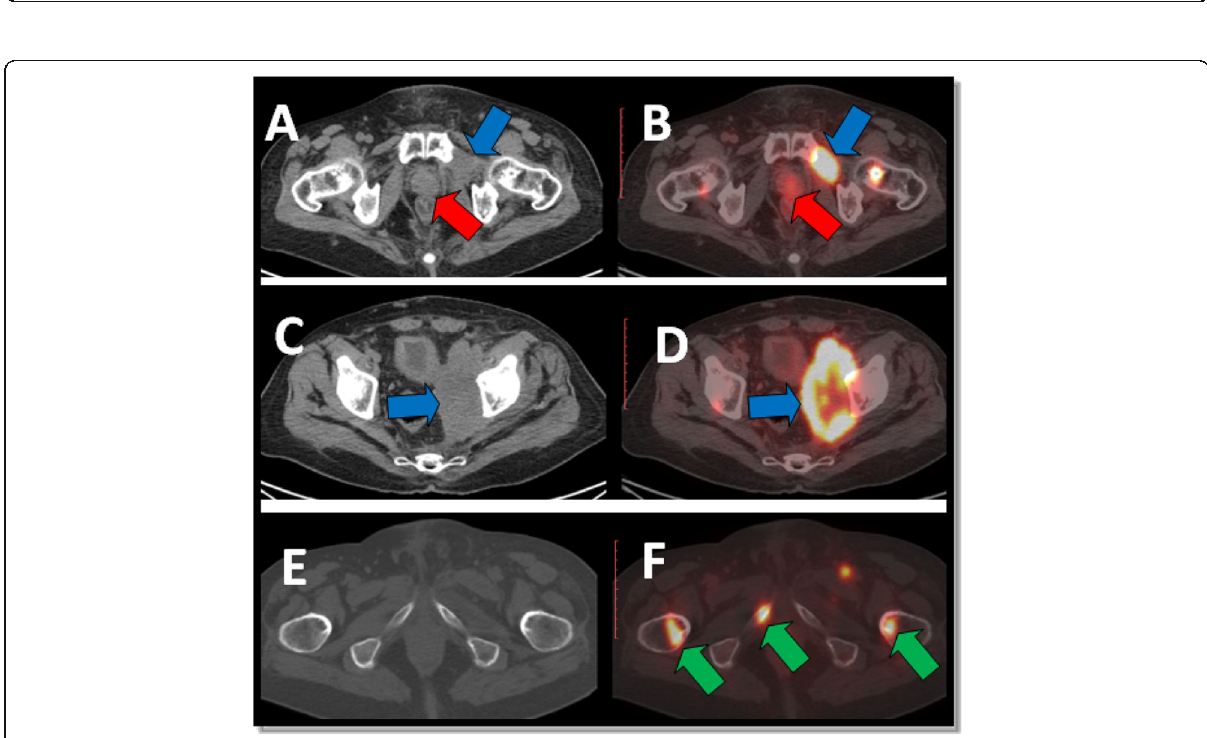
Fig. 5 Axial non-contrast CT and PET-CT images for a 61-year-old male patient with history of prostate cancer for which he had radiotherapy and hormonal therapy. Images a and b showed focal prostatic 68Ga-PSMA activity with SUVmax = 4.7 (red arrows) denoting residual neoplastic lesion. Images a – d showed marked 68Ga-PSMA activity by metastatic left iliac nodal mass lesion encroaching on the left obturator and sacro- sciatic foramina with SUVmax = 50.1 (blue arrows). Images e and f showed marked 68Ga-PSMA activity by metastatic osseous lesions involving the right inferior pubic ramus and both proximal femora, the most active shows SUVmax = 45.4 (green arrows) with no gross corresponding CT